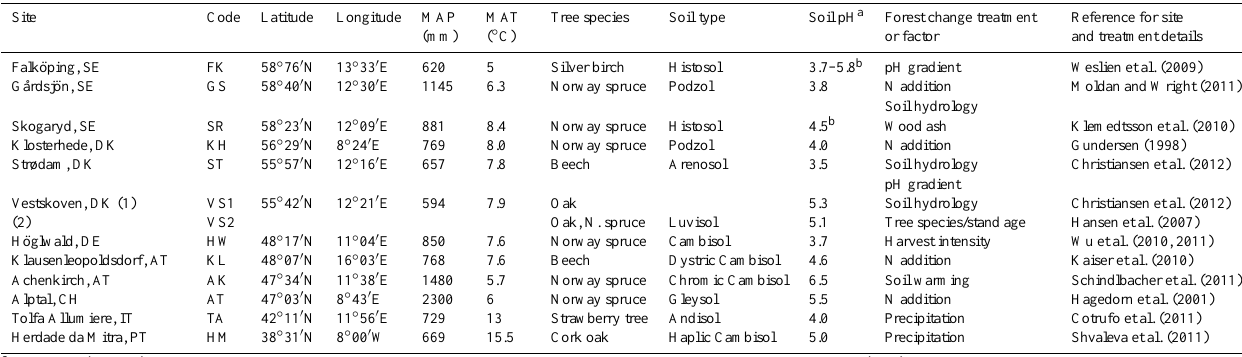
Table 1. NitroEurope C2 sites (ordered north to south) – characteristics and treatments.